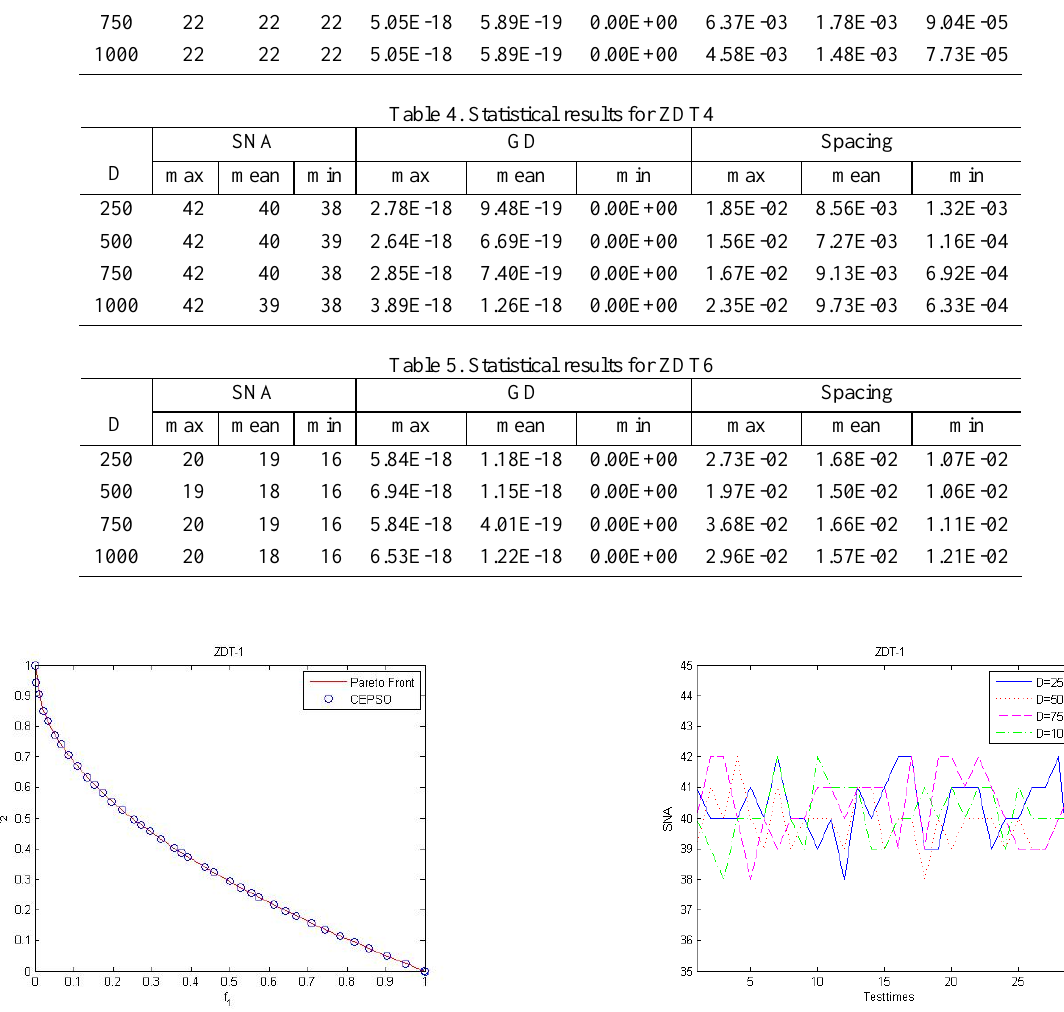
Figure 2 Pareto front of ZDT1(D=1000) Figure 3 SNA of